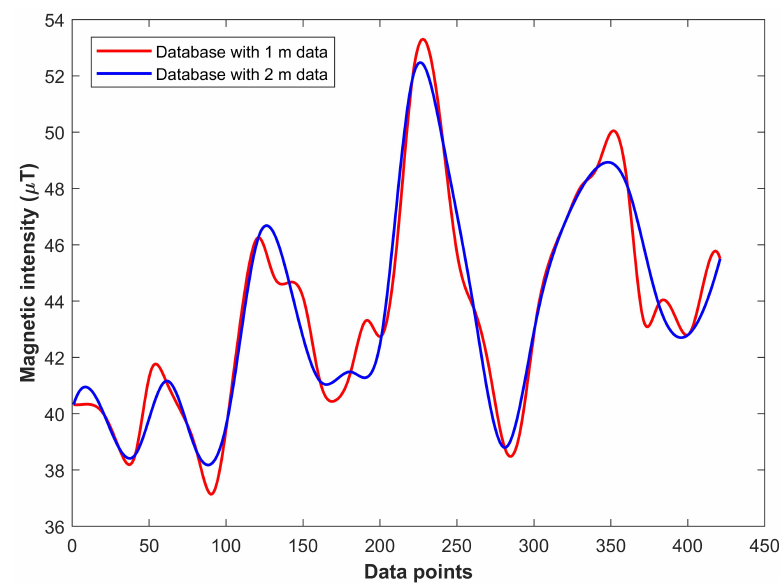
Figure 15. Comparison of databases prepared with 1 m and 2 m separated